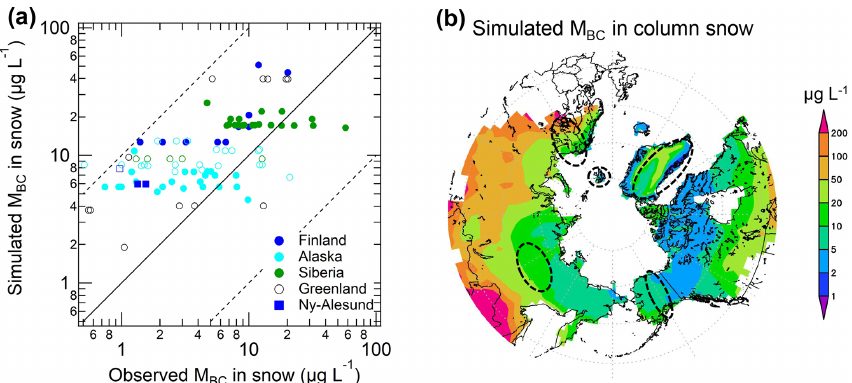
Figure 5. (a) Scatter plot of observed and simulated BC mass concentrations ( M BC ) in snow in Finland (blue circles), Alaska (light blue), Siberia (green), Greenland (black), and Ny-Ålesund (blue squares). Observed data are taken from Mori et al. (2019). Simulation results (monthly averages) are shown for individual sampling points (latitude, longitude) and periods (years, months). Closed and open circles indicate M BC in column snow and surface snow, respectively. The 1 : 1 line (solid black line) and the 10 : 1 and 1 : 10 lines (dashed lines) are also shown. (b) Simulated M BC in column snow at high latitudes in the Northern Hemisphere in March (2009–2015). Dashed circles indicate the approximate area where snow samplings were performed (Mori et al.,